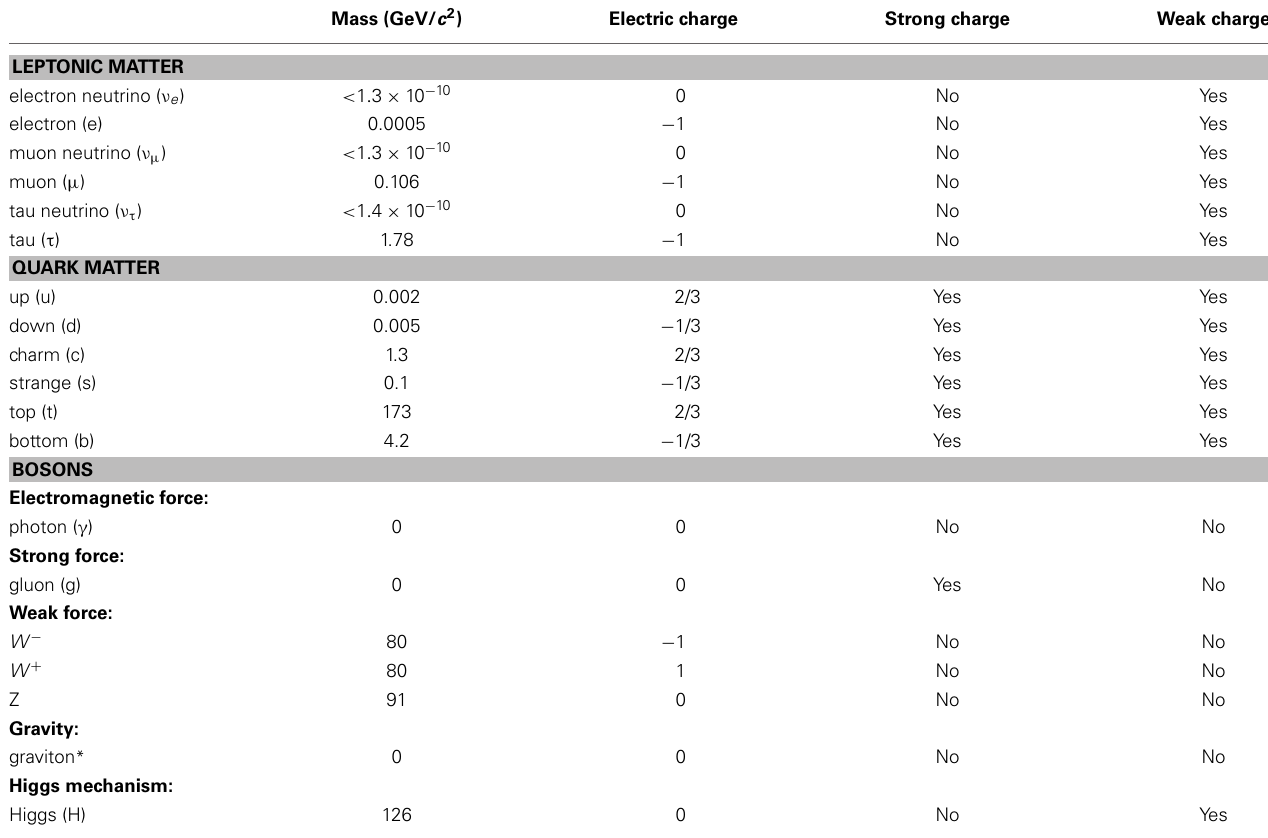
Table 1 | Table of the fields/particles that are considered fundamental. Mass (GeV/ c 2 ) Electric charge Strong charge Weak